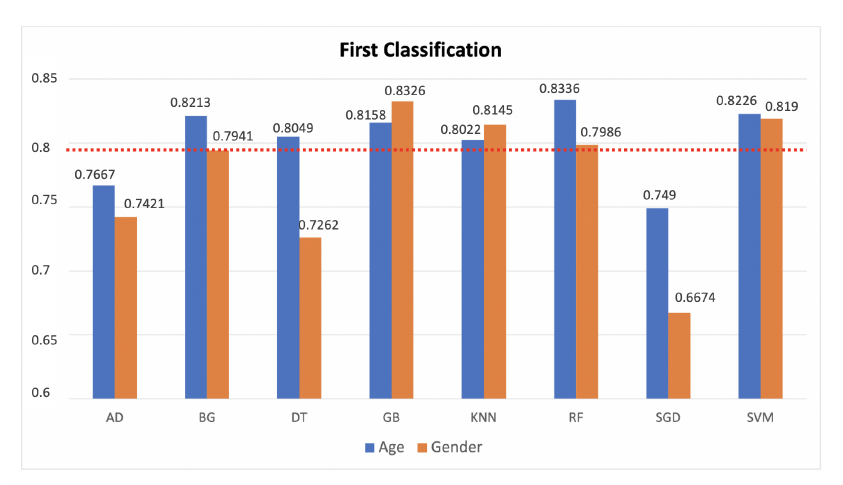
Figure 4. The results of the age and gender classification using different classifier. The accuracies over the red line are taken in considerations.